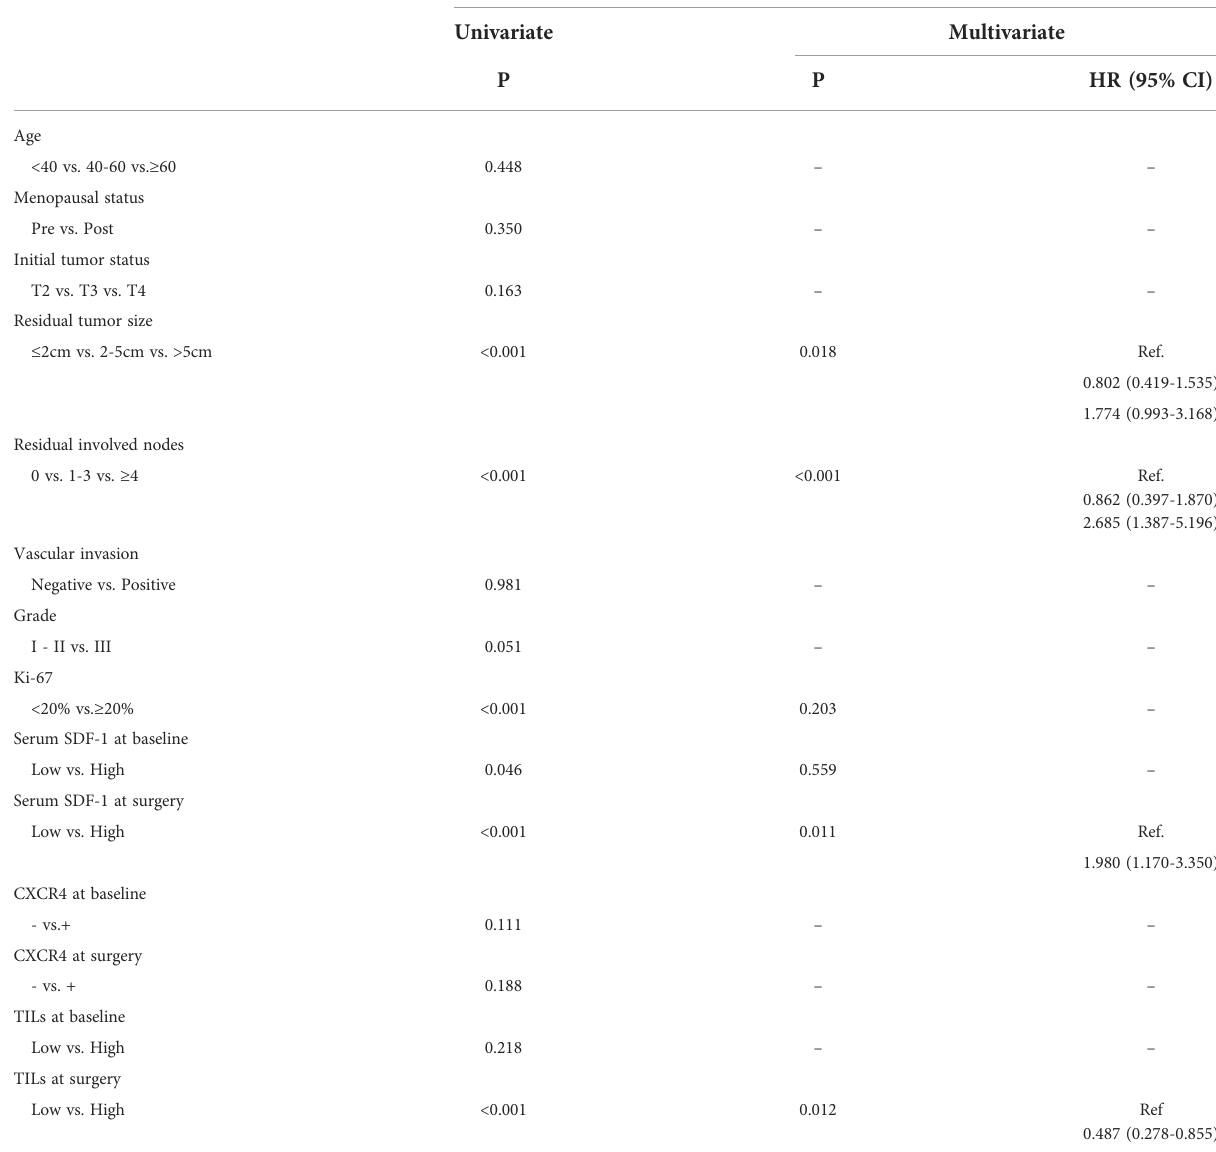
TABLE 2 Univariate and multivariate survival analysis of non-pCR